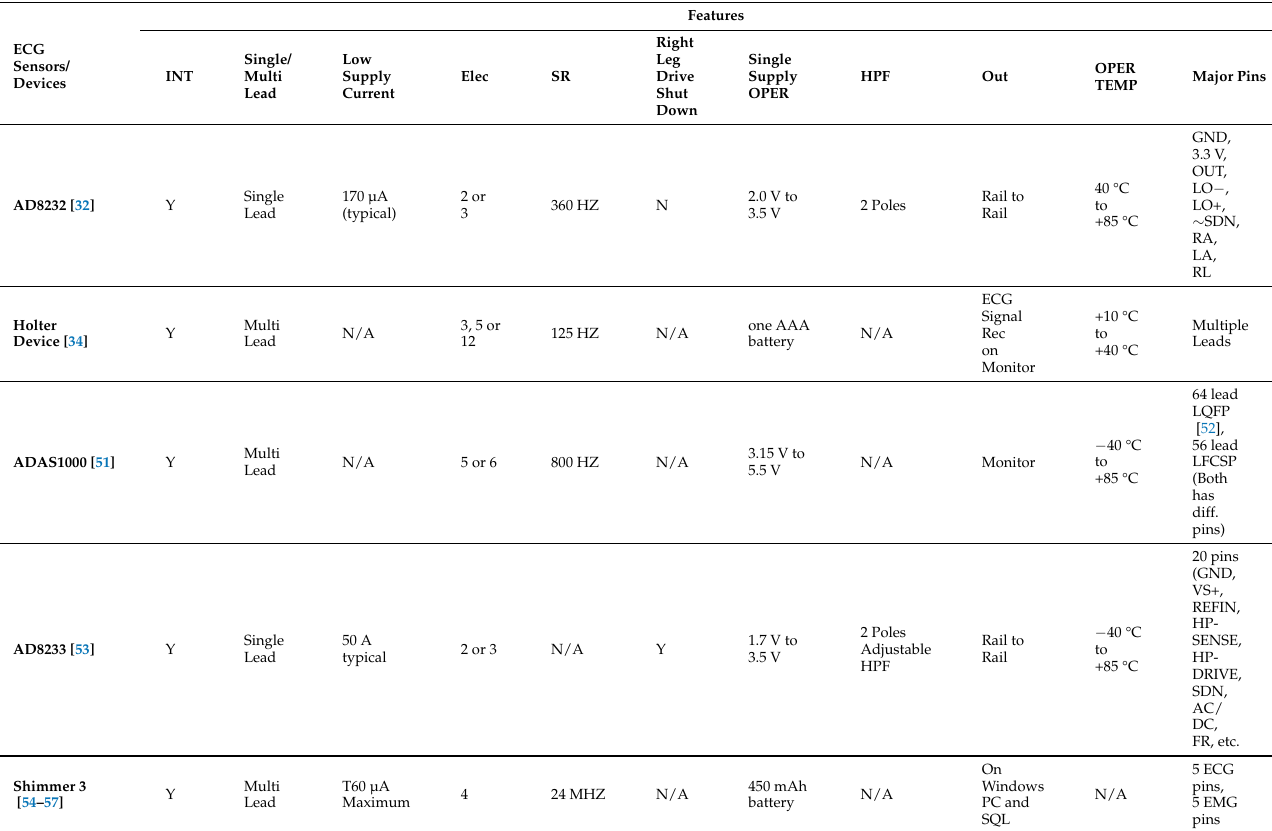
Table 9. Features of ECG